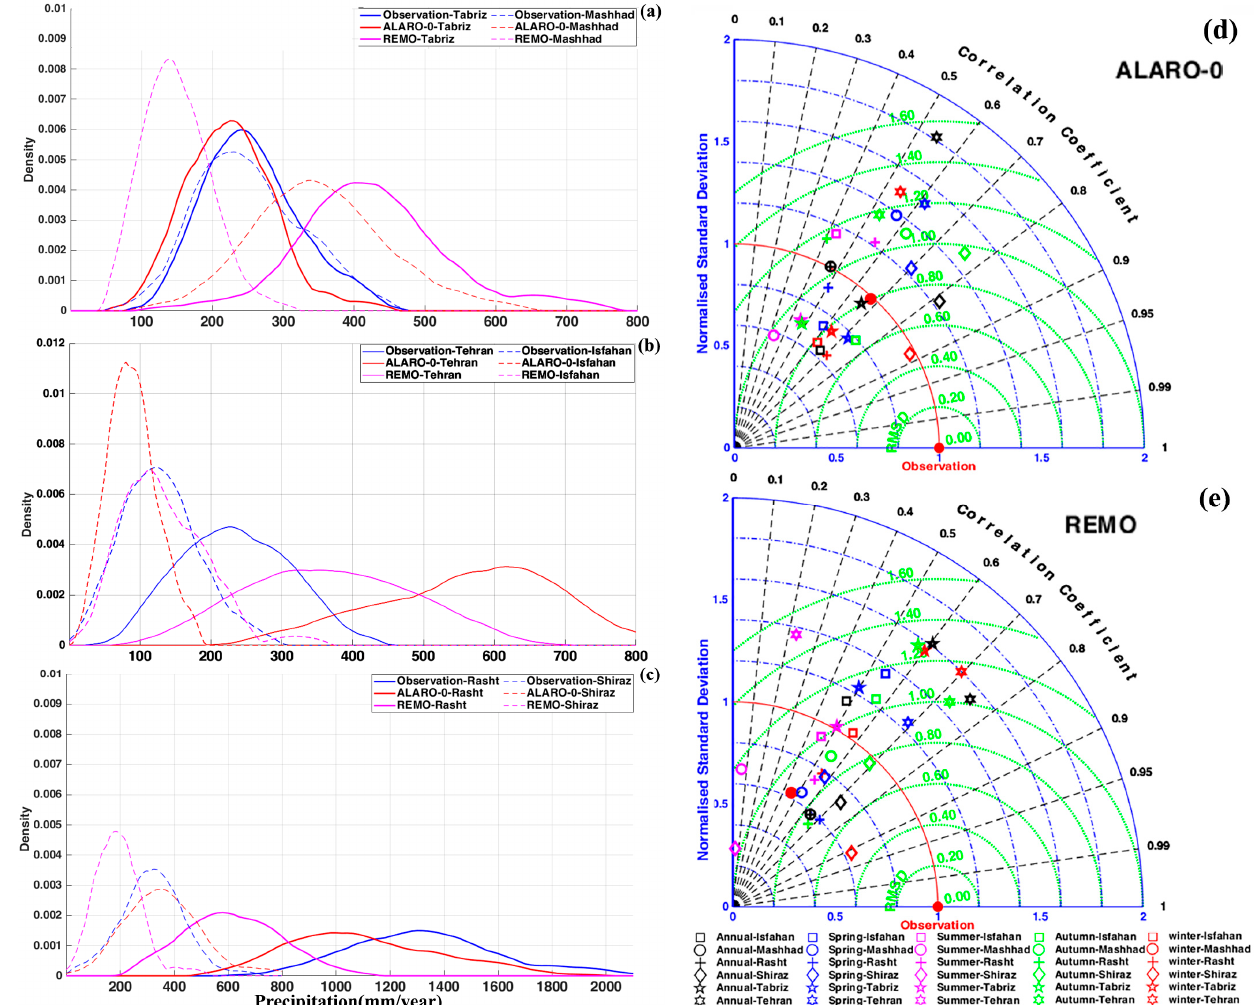
Figure 12. PDFs for total annual precipitation comparing ALARO-0 and REMO with observations over the studied stations: ( a ) Tabriz and Mashhad, ( b ) Isfahan and Tehran, ( c ) Shiraz and Rasht during 1980–2017. Taylor diagrams comparing ALARO-0 ( d ) and REMO ( e ) for the annual and seasonal relative humidity over six studied stations during 1980–2017. ( d , e ) Taylor diagrams showing ALARO-0 and REMO scores over six stations for annual and seasonal